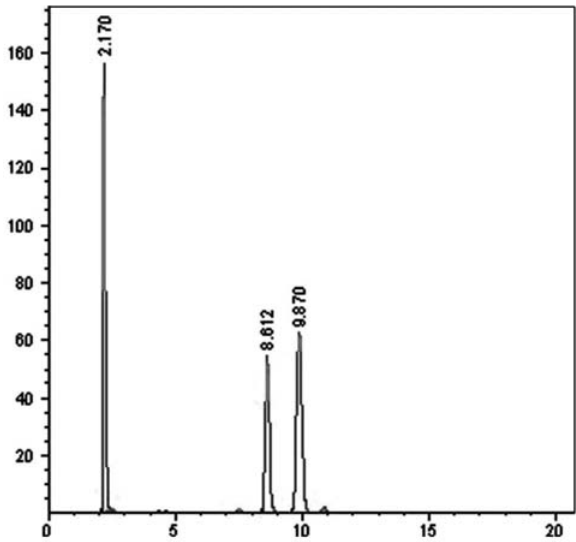
Figure 4. HPLC chromatogram of a mixture of famotidine (Rt 2.17 min), Ibuprofen (Rt 9.87 min) and ibuprofen impurity (Rt 8.61 min)